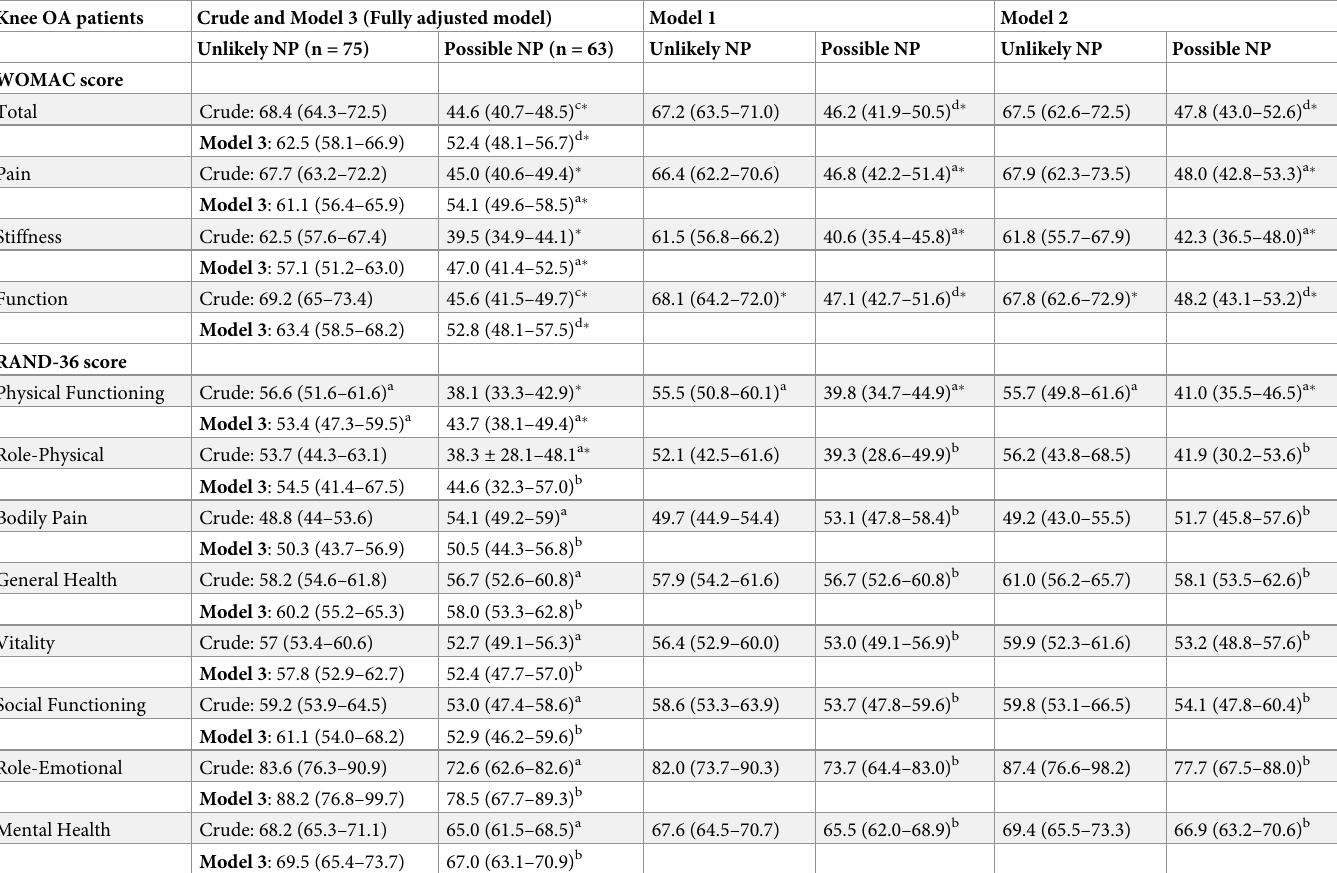
Table 3. Knee OA crude and stepwise ANCOVA adjusted WOMAC and RAND-36 scores §